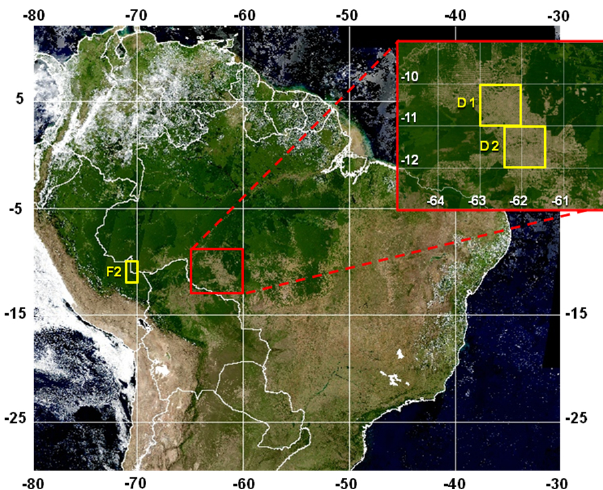
Fig. 5. Areas selected in South America for the surface albedo change radiative forcing evaluation (LURF). The yellow squares correspond to the deforested areas (D1 and D2) and forested (F2) areas selected.